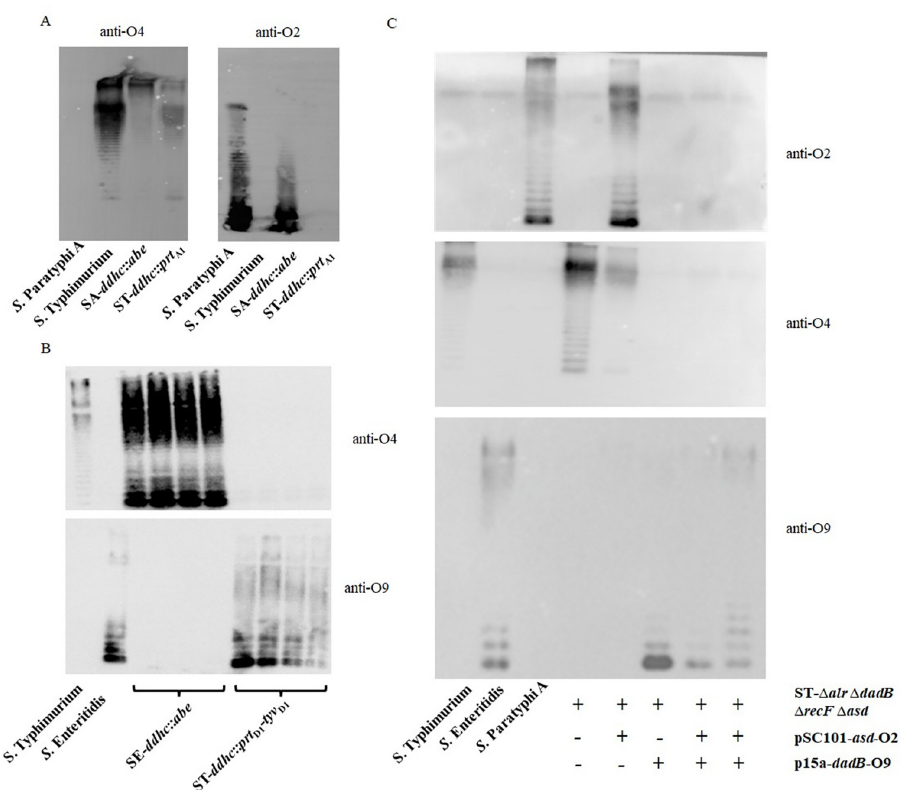
Fig 2. Immunoblots analysis. LPS was extracted from the S . enterica mutants exhibiting O2&O4 (A), O4&O9 (B) and O2&O4&O9 (C) O-serotypes and separated on a 12.5% (w/v) polyacrylamide gel by tricine-SDS-PAGE. Samples were then transferred to a nitrocellulose membrane for immunoblotting with anti-Par O2, anti-Abe O4 or anti-Tyv O9 antisera. The detected bands corresponded to LPS with different side-branch O-unit